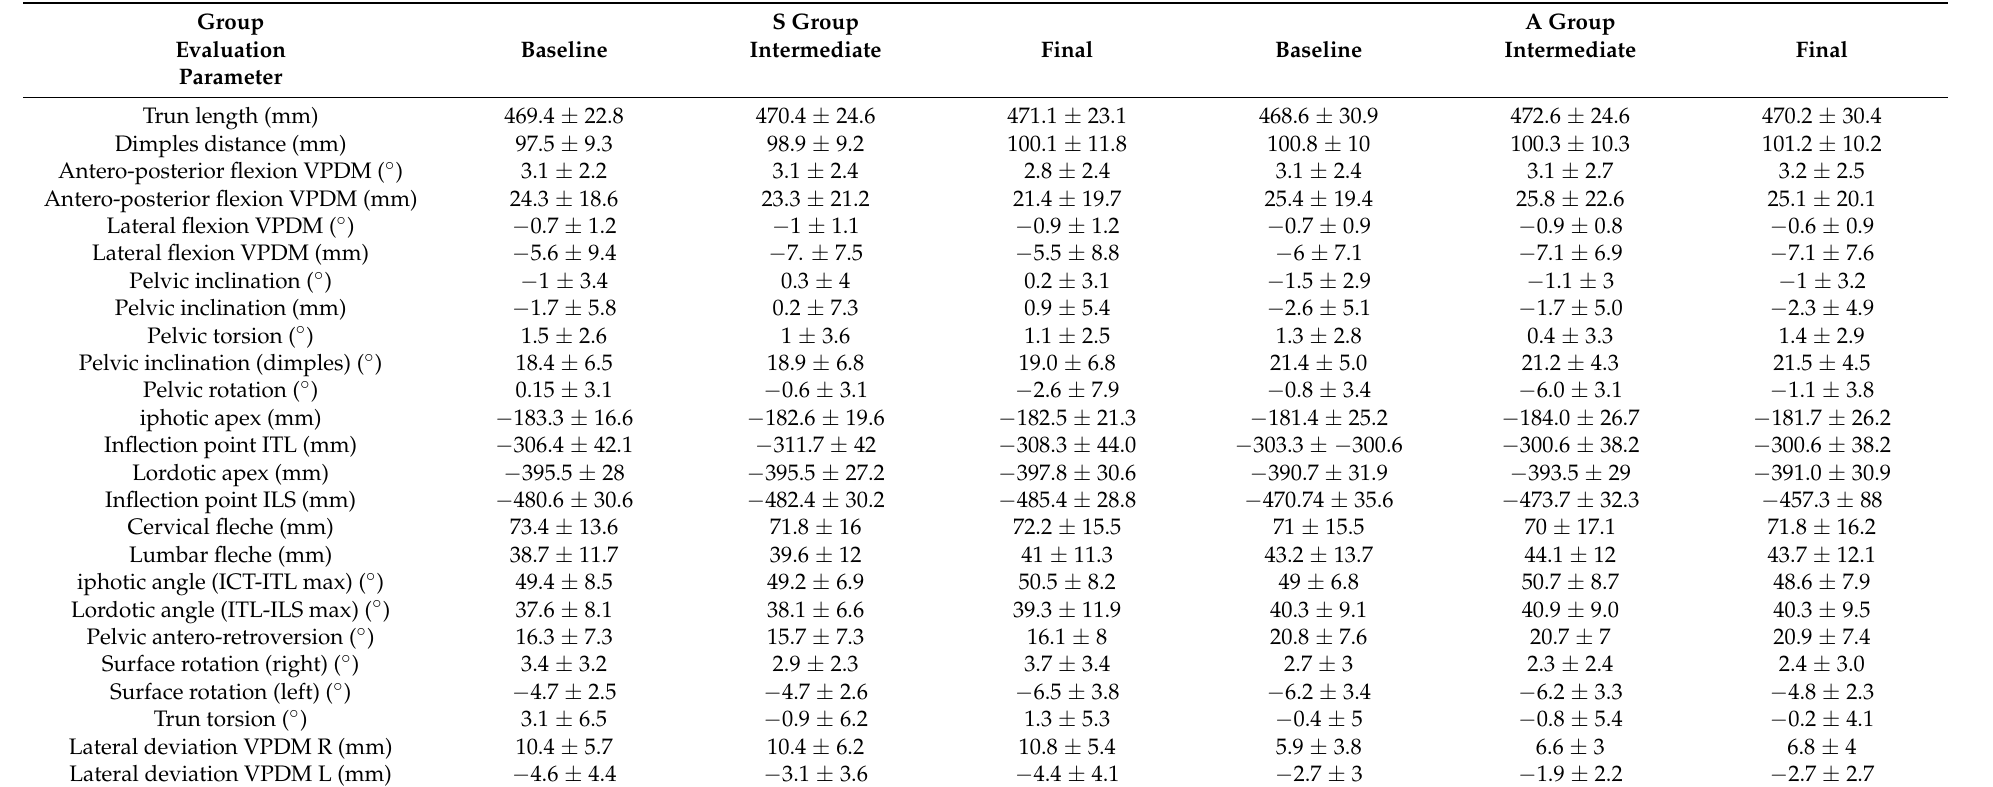
Table 3. Baseline-, intermediate-, and final-intervention spine assessment (mean values ± s) of S and A groups. S Group A